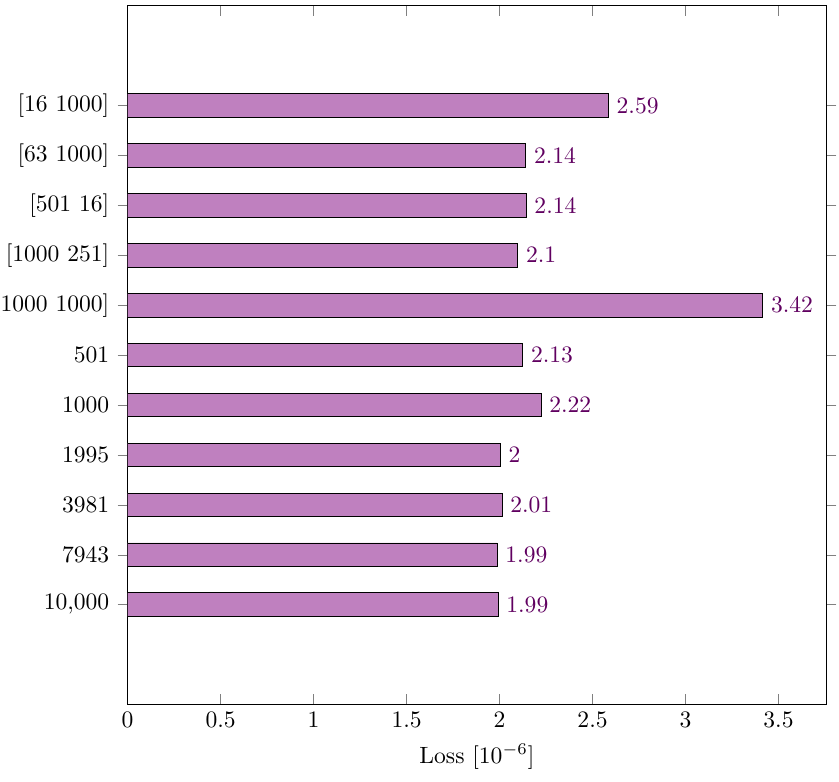
Figure 12. Errors for Patience 100, Optimizer—Adam.